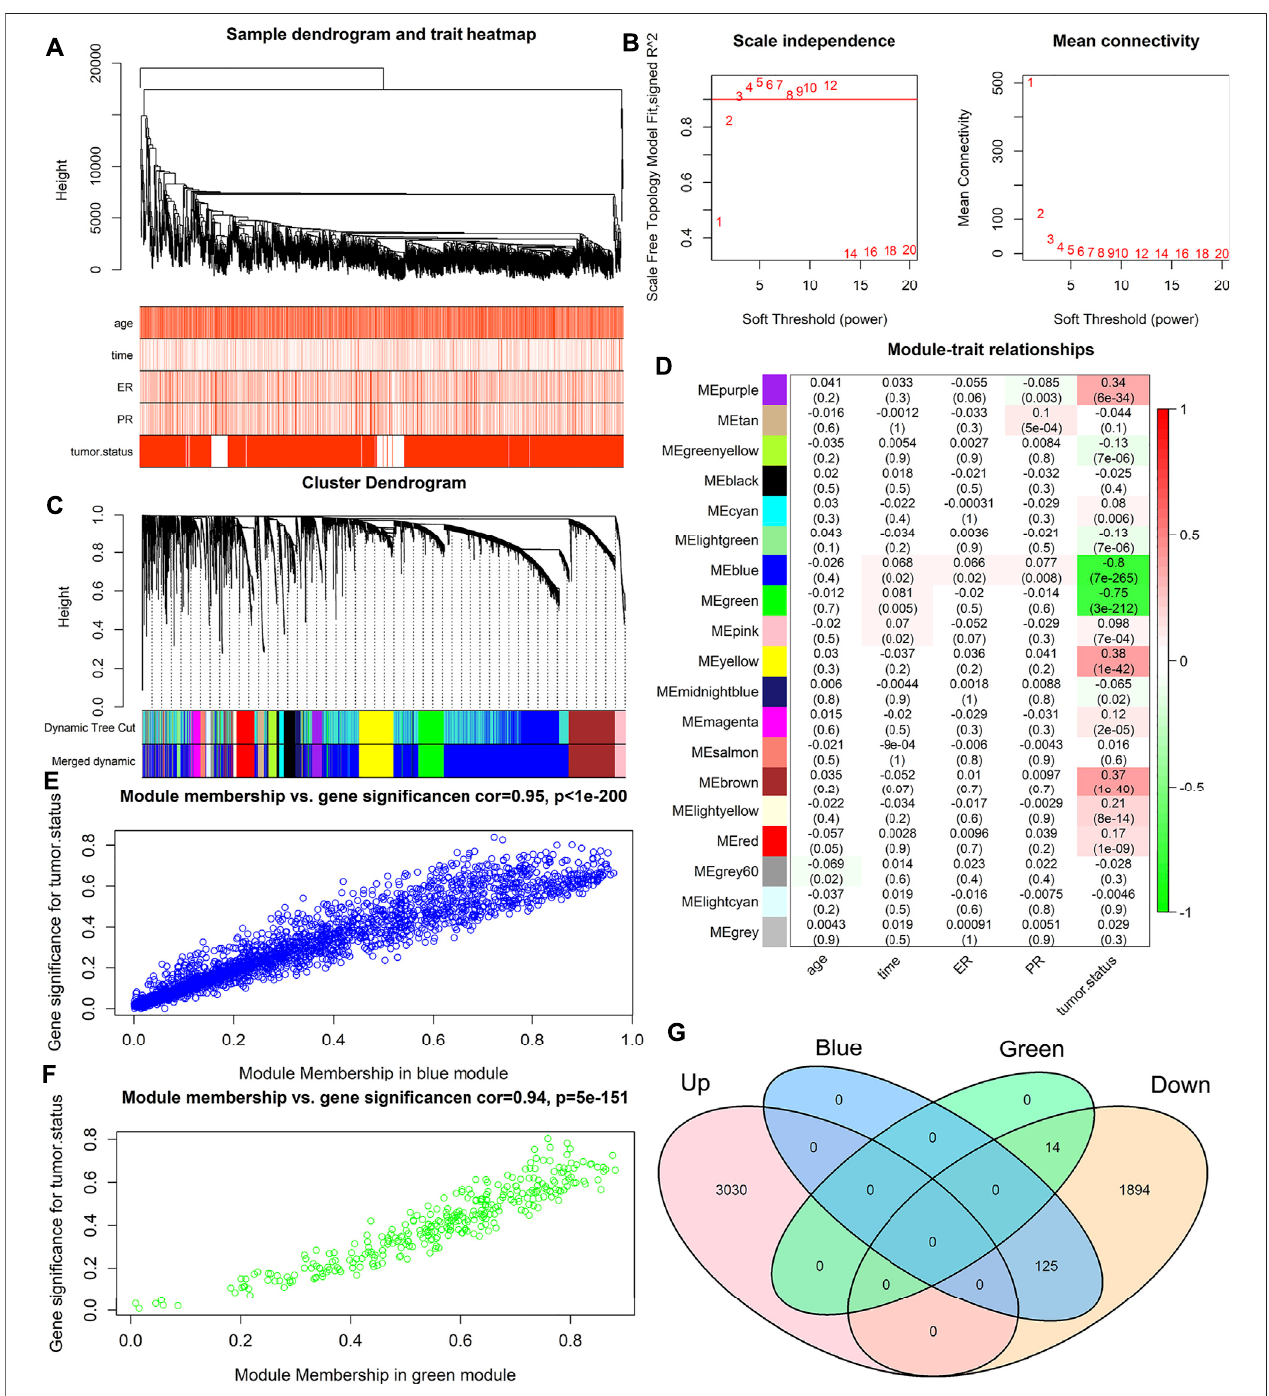
FIGURE 3 | WGCNA analysis of DEGs. (A) is a sample clustering tree diagram. (B) is the scale-free index of various soft threshold power, and the average connectiondegreeofvarioussoftthresholdpower. (C) isthemodulegenecolorblockofclusteranalysis.The fi rstlineisthemodulegeneratedbythe fi rstclustering,and thesecondlineisthemergedmodule(whenthesimilaritybetweendifferentmodulesreaches0.8,theyaremergedintoonemodule). (D) istheheatmapofthecorrelation coef fi cient between module genes and clinical features. (E) is the scatter plot of the distribution of the Module Membership (MM) and the Gene Signi fi cance (GS) in the blue module. (F) is the scatter plot of the distribution of MM and GS in the green module. (G) is the Venn diagram of the hub gene and the expression up-regulated gene and the expression down-regulated gene.